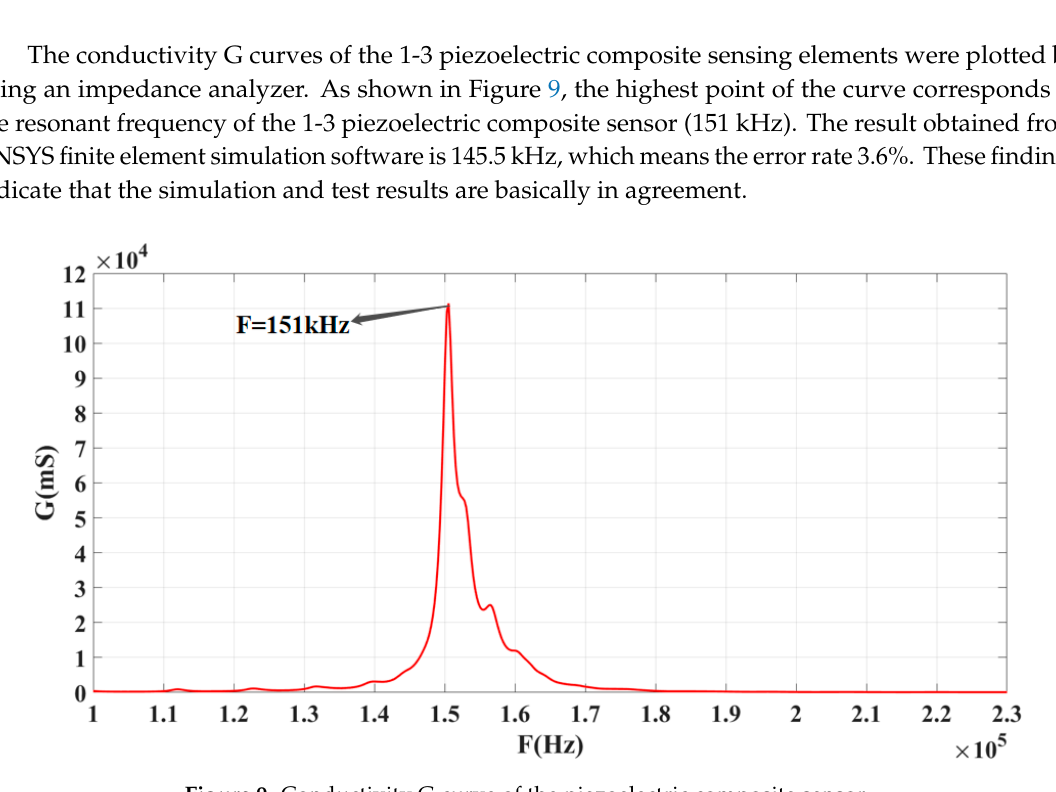
Figure 9. Conductivity G curve of the piezoelectric composite sensor.